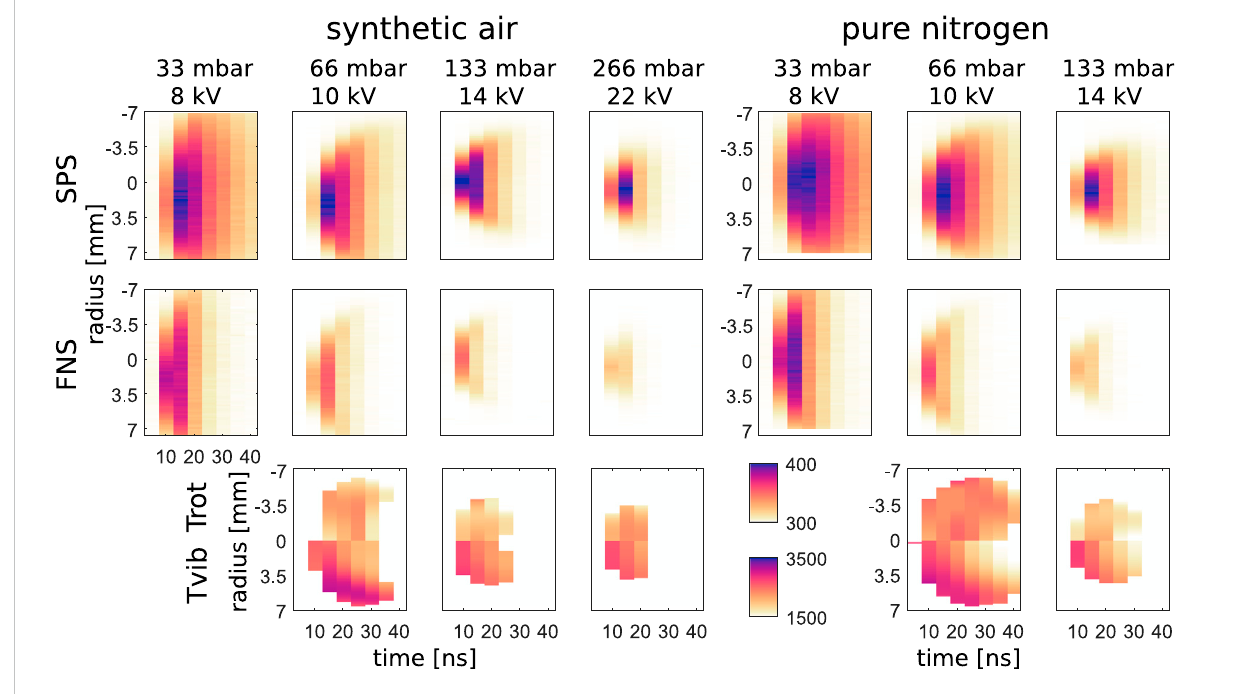
FIGURE 11 Array of heat maps, streamers are shown propagating to the left, showing the intensities of SPS and FNS as well as the rotational and vibrational temperatures of SPS for various pressures in synthetic air and pure nitrogen. Spectra are captured with a 5 ns temporal gate and step. FNS intensities are normalized to the SPS intensities. The bottom row shows temperatures fi tted to the Abel inverted